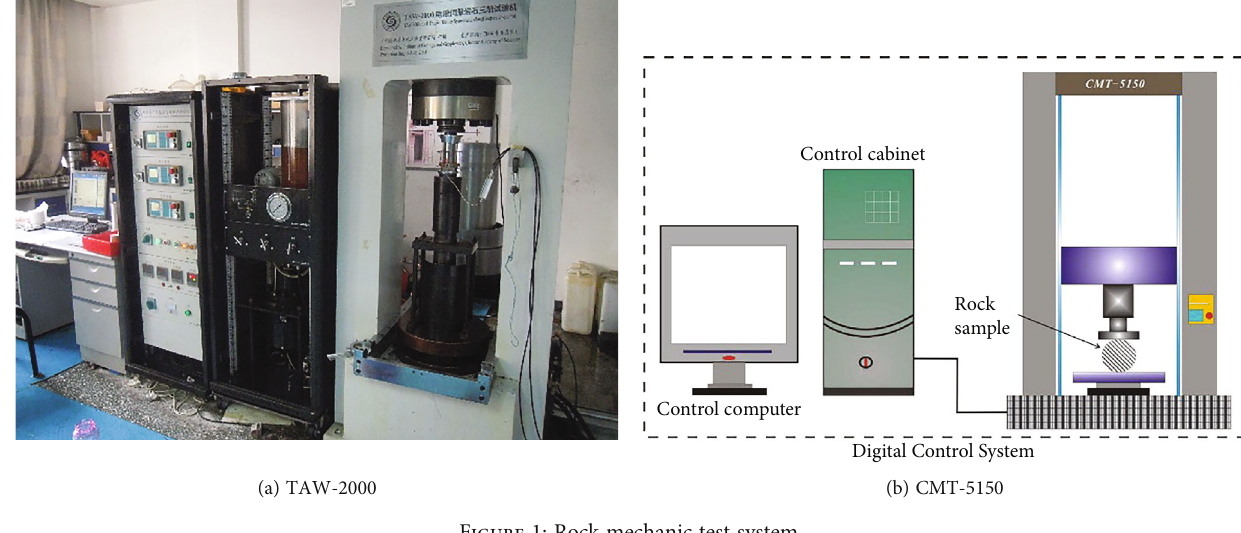
Figure 1: Rock mechanic test system.